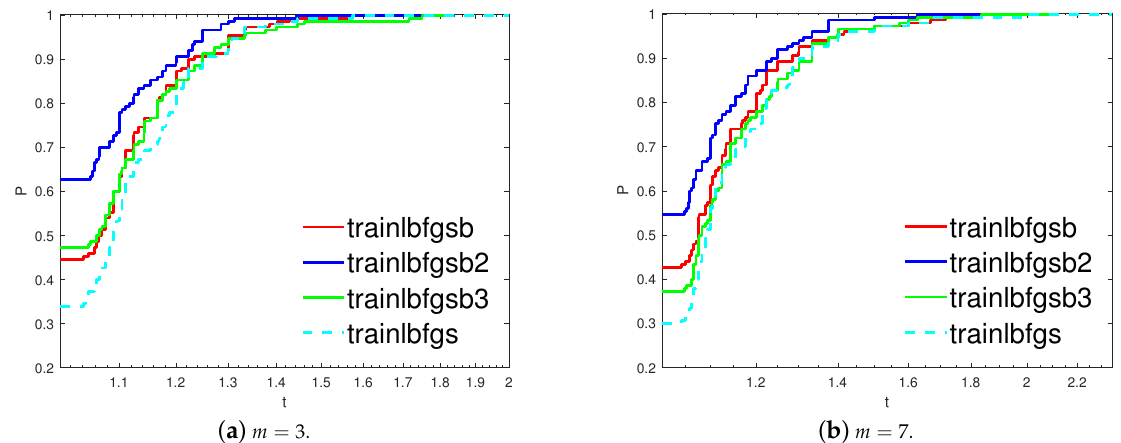
Figure 7. Log 10 scaled performance profiles based on accuracy for the Escherichia coli classification problem.